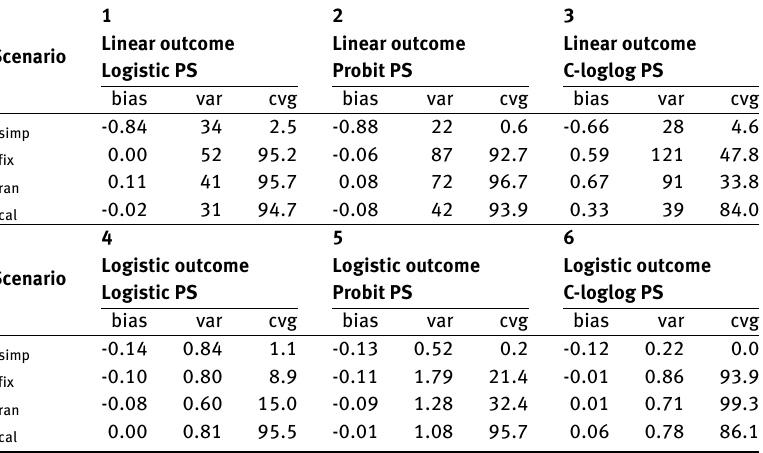
Table 2: Simulation results: bias, variance ( × 10 − 3 ) and coverage (%) of 95% confidence intervals based on 1 , 000 Monte Carlo samples; the outcome is linear and logistic linear mixed effects model and the propensity score is logistic, probit or comple- mentary log-log